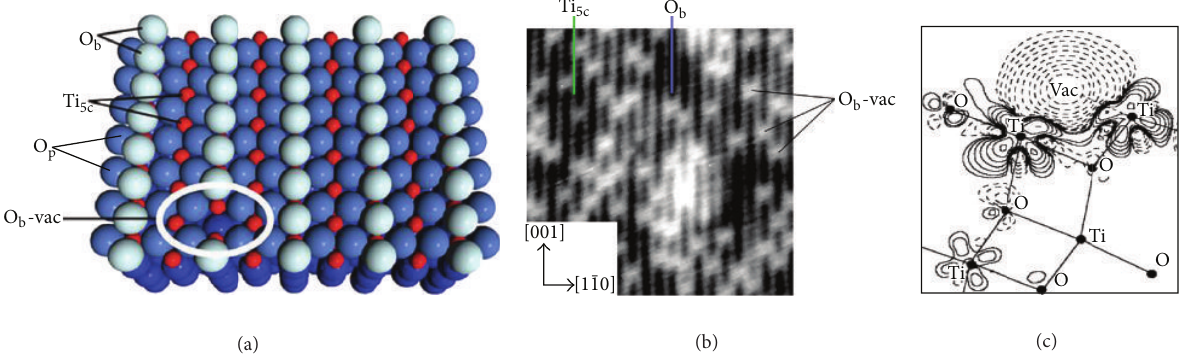
Figure 3: (a) Pseudospace-filling model of ideal bulk-terminated TiO 2 (110) with a bridging oxygen vacancy. Blue (red) spheres are oxygen (titanium) atoms. (b) STM image of (1 × 1) TiO 2 (110) surface. The bright rows correspond to surface Ti 5 is bridging oxygen (O b ) and O b -vacs are marked as the bright protrusions in the black row [43]. (c) Redistribution of the surface electronic density caused by single oxygen vacancy [64].